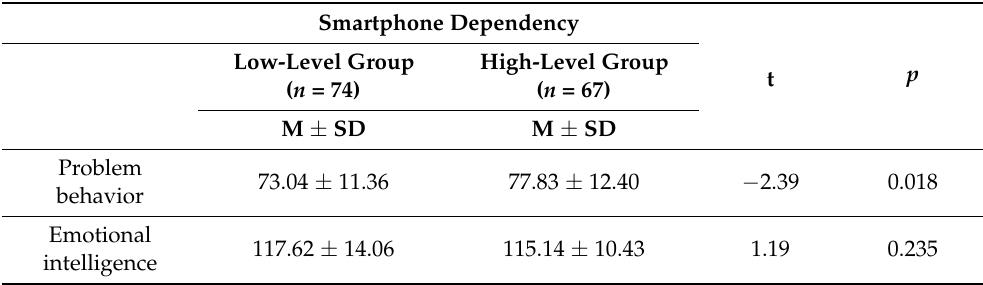
Table 3. Differences in children’s problem behavior and emotional intelligence according to the level of mothers’ smartphone dependency. ( n = 141).